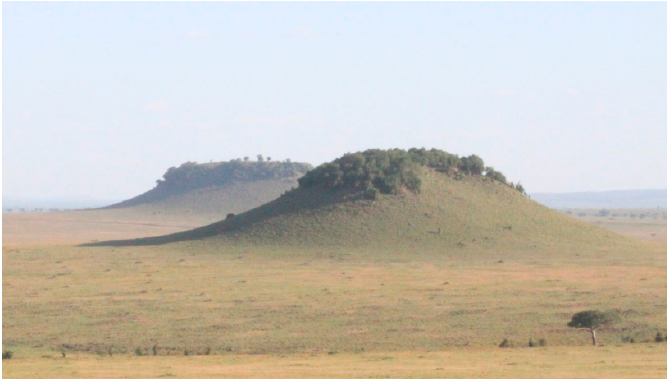
Figure 5. Inselbergs typically occur as abruptly rising, solitary, monolithic hills or mountains. They are particularly common in the tropics and subtropics [47]. This photo was taken in the southern Mara Triangle, where inselbergs are quite common.